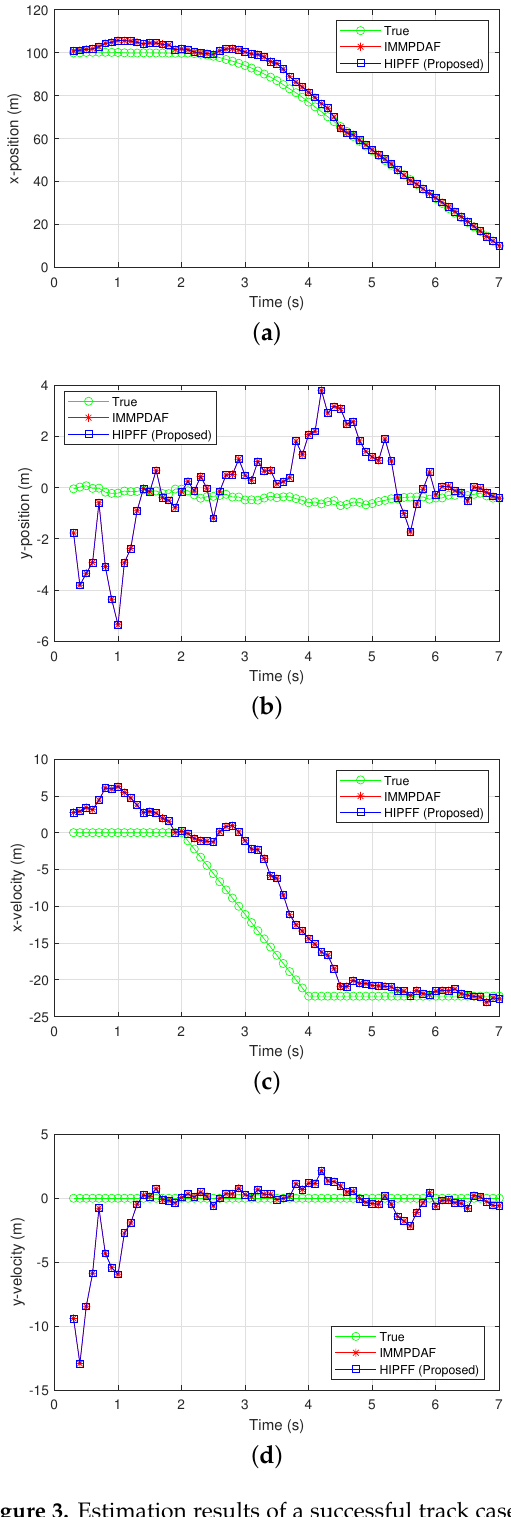
Figure 3. Estimation results of a successful track case: ( a ) x-position; ( b ) y-position; ( c ) x-velocity; and ( d )